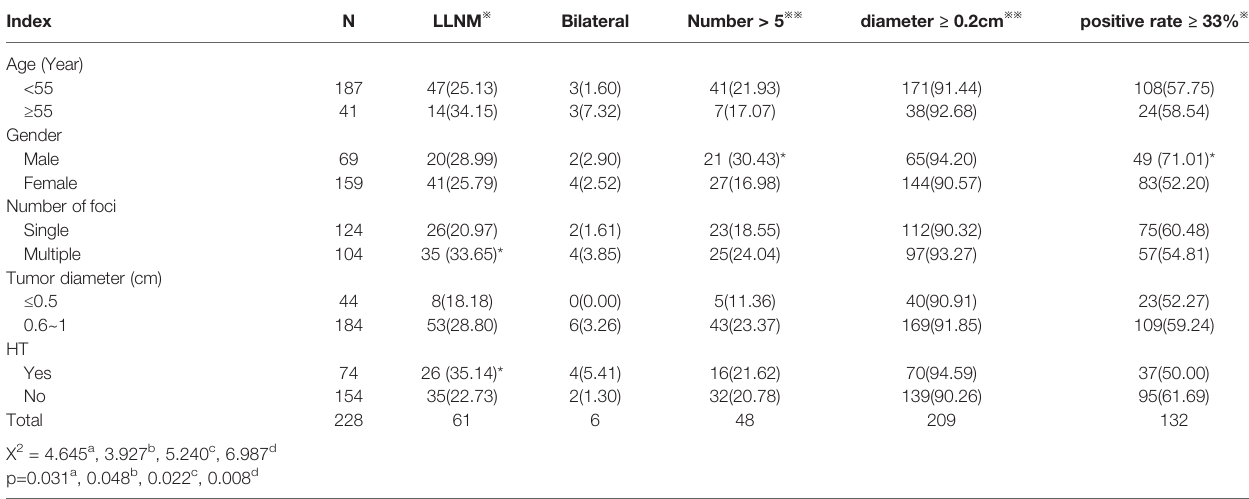
TABLE 5 | Analysis of characteristics between different subgroups of LNM (n %).